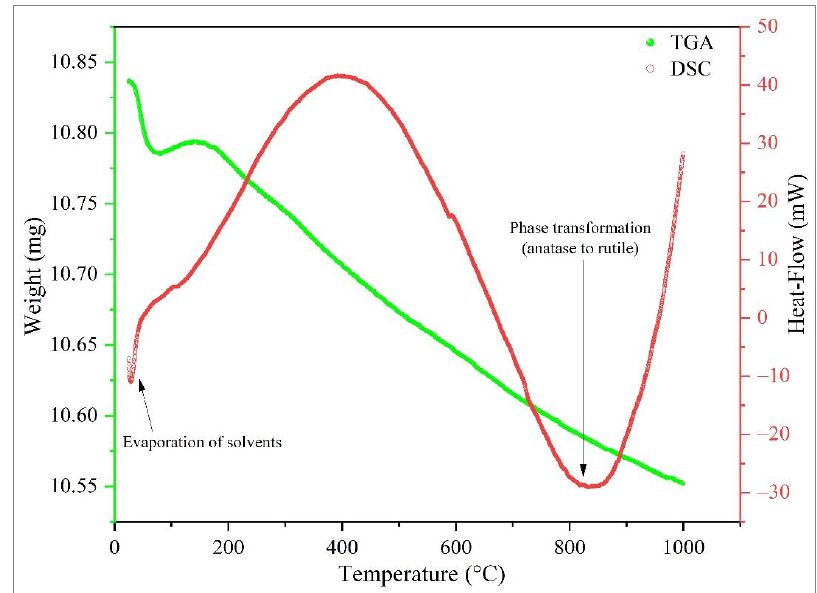
Figure 7. TGA and DSC thermograms of biosynthesized TiO 2